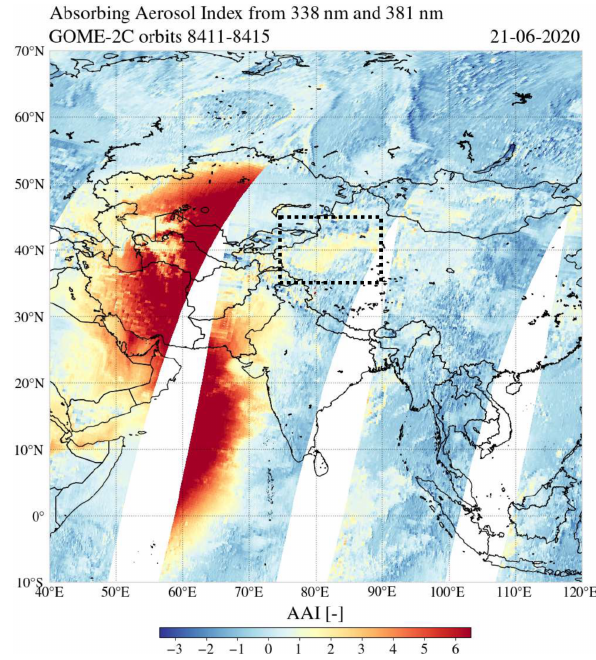
Figure 21. The absorbing aerosol index from the 338 and 381nm wavelength pair by GOME-2C on 21 June 2020 over Asia in orbits 8411–8415. The Taklamakan Desert is located in the rectangular dotted